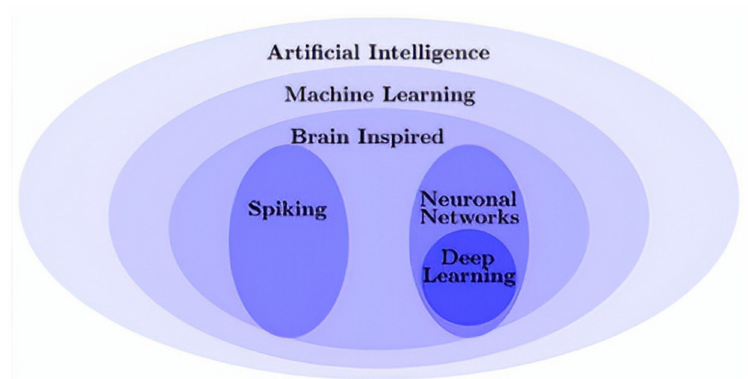
Figure 19. Venn diagram of artificial intelligence with its categories